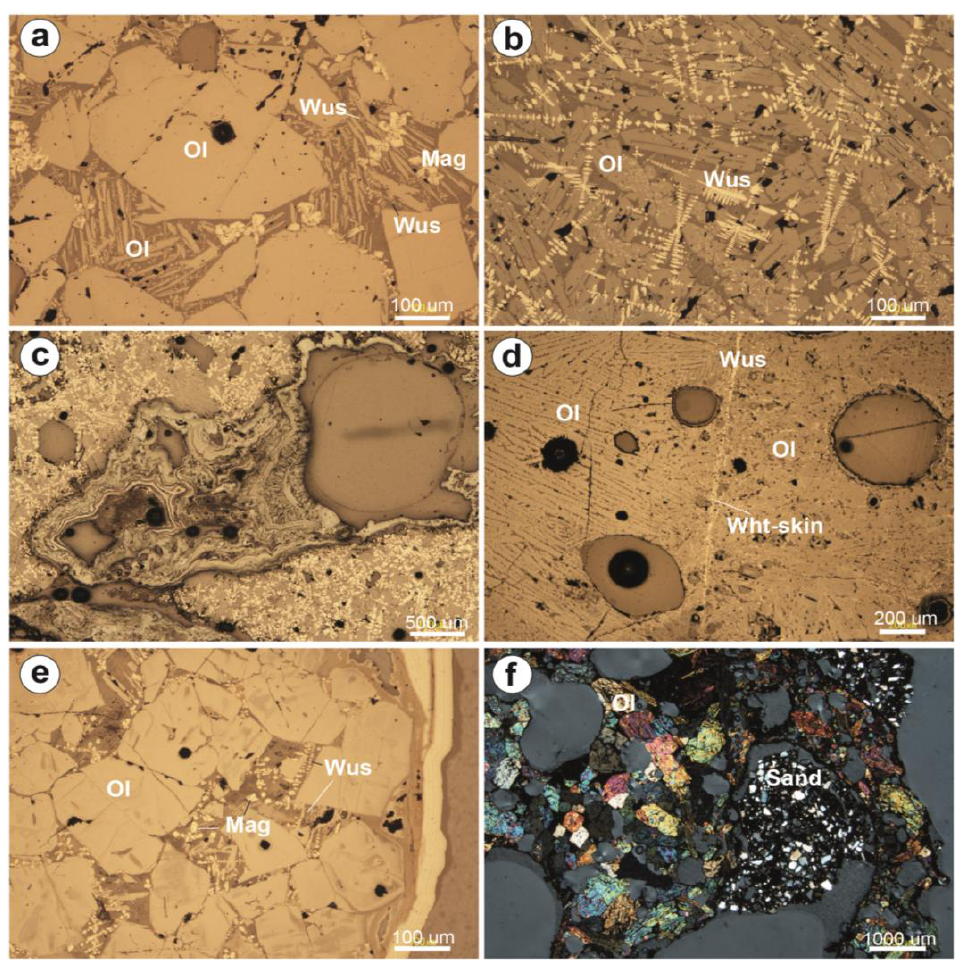
Figure 3. Photomicrographs showing microtextures of slags. ( a ) Massive and skeletal olivines and cruciform-skeletal crystals of magnetite in Medieval Group 1. ( b ) Skeletal olivines and dendritic wuestite intergrowing within olivines in Group 2. ( c ) Dendritic wuestite and botryoidal structure surrounding a pore. ( d ) white lines indicative of various flows in Group 3. ( e ) Massive olivines and cruciform-skeletal crystals of magnetite in Roman Group 4. ( f ) Massive olivine and sandstone fragment in Roman cinder-slag. ( a – e ) in reflected light mode and ( f ) in transmitted light in cross-polarized light mode. Abbreviations after [36]: Ol: Olivine, Wus: Wuestite, Mag: Magnetite, Wht-skin: white skin.